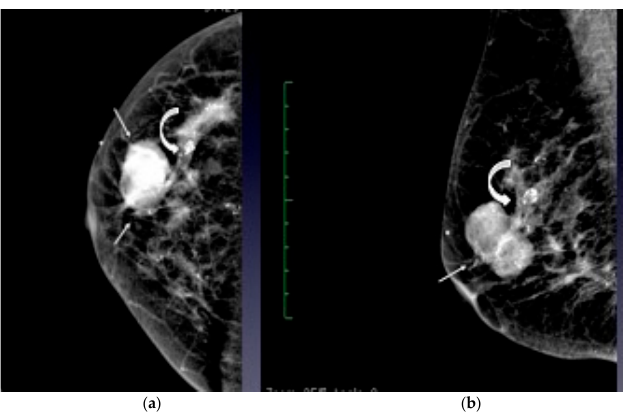
Figure 1. Craniocaudal ( a ) and mediolateral oblique ( b ) mammograms of the right breast show a lobulated mass with irregular margin, mild spiculation and coarse calcification (curved arrow) in the right mid-outer quadrant.